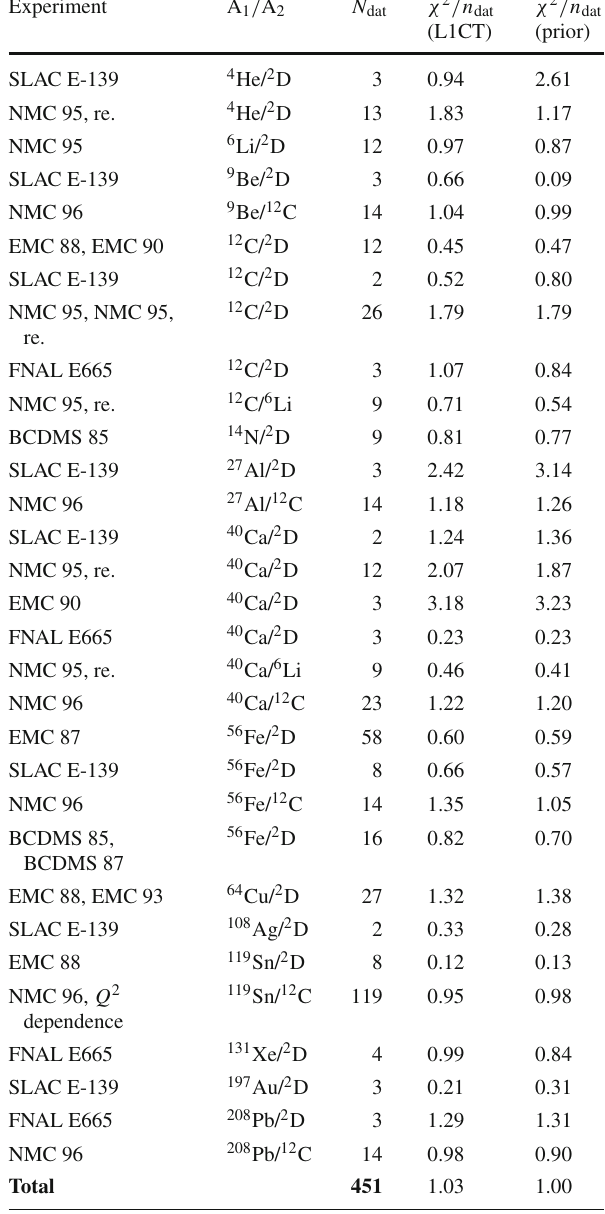
Table 4 The averaged values for χ 2 / N dat for each experiment in a Level 1 closure test compared with values obtained using the nCTEQ15 distributions